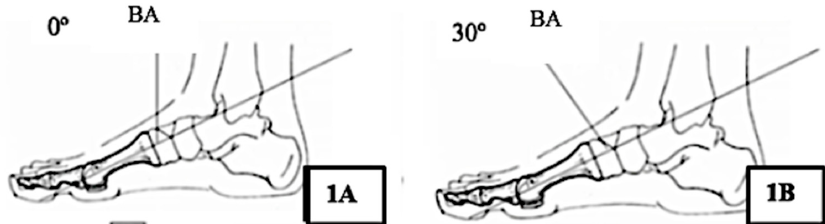
Figure 1. Position of the X-ray beam at a distance of 100 cm to obtain precision in the images. Abbreviations: BA: Beam angle. ( A ) relationship between the angulations with an X-ray beam projection at 0°; ( B ) Relationship between the angulations with an X-ray beam projection at 30°.